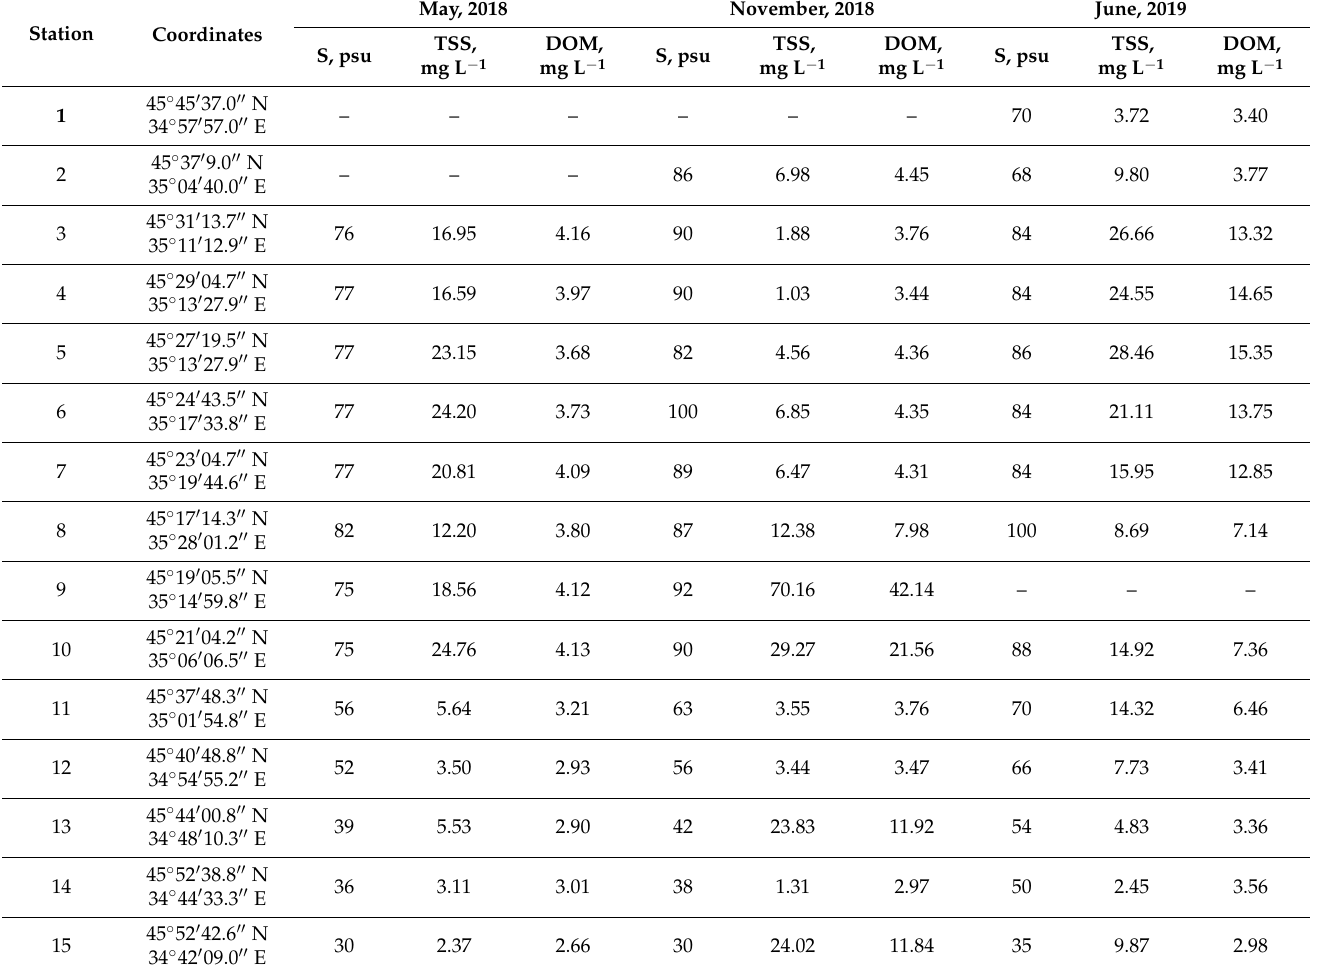
Table 1. Characteristics of sampling points in Bay Sivash